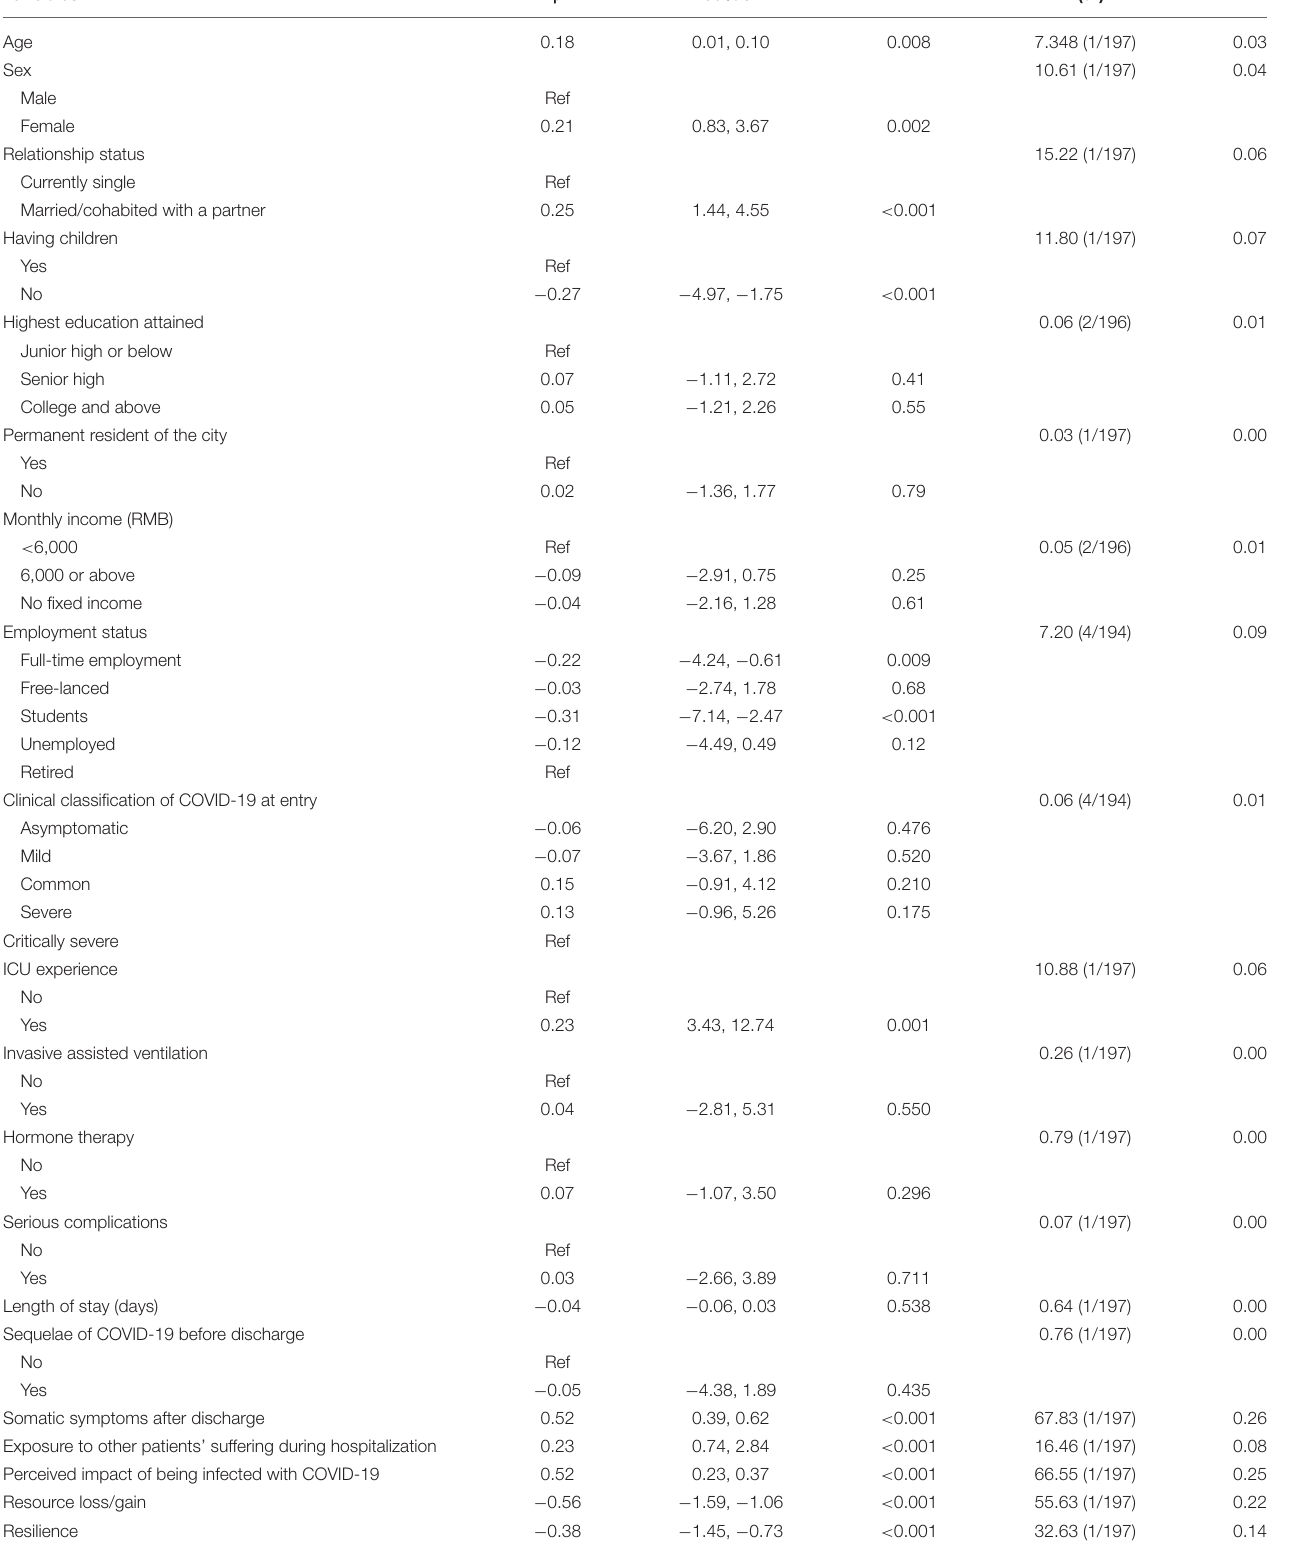
TABLE 2 | Background factors, physical factors and psychological factors of PTSD symptoms.